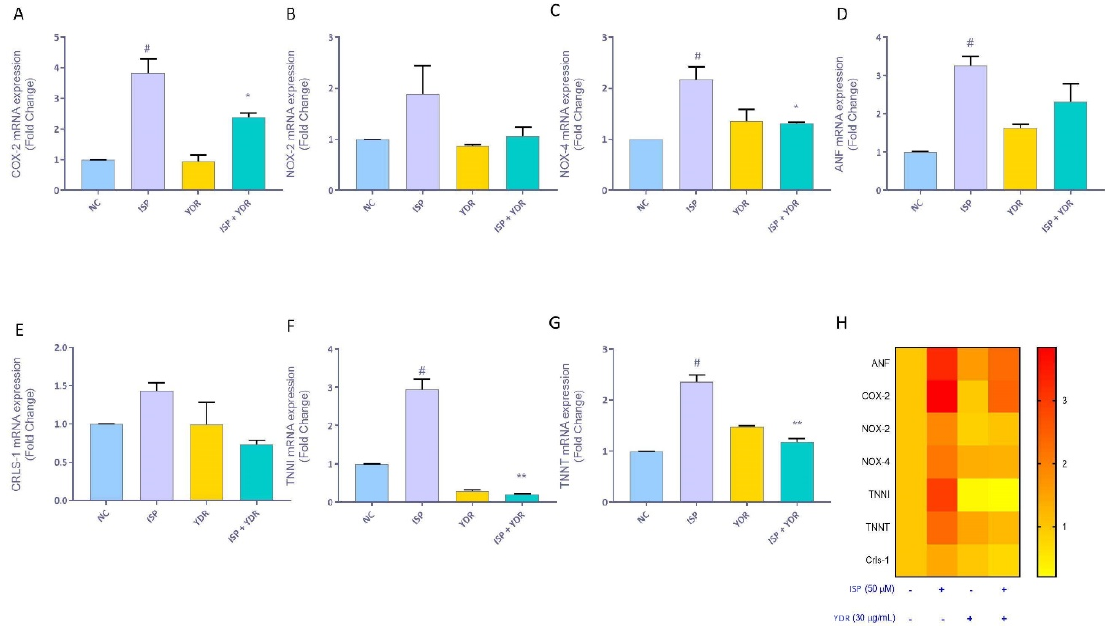
Figure 7. Down-regulation of cardiac-hypertrophy-associated non-clinical and clinical molecular biomarkers by Yogendra Ras (YDR) in the isoproterenol (ISP)-stimulated H9C2 cells. H9C2 cells stimulated with ISP showed an increase in the mRNA expression levels of the pro-inflammatory mediator genes: ( A ) Cyclooxygenase-2 (COX-2), ( B ) NADPH oxidase-2 (NOX-2). and ( C ) NADPH oxidase-4 (NOX-4) using quantitative real-time PCR.